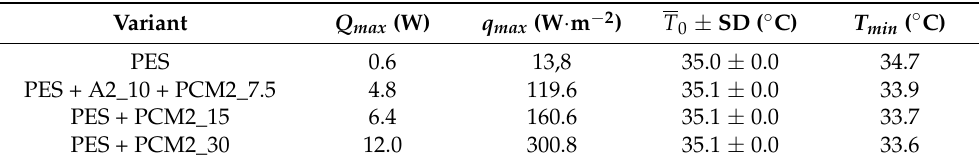
Figure 10. The course of changes in the mean values of heat loss flux density on the skin model (under isothermal conditions). (under isothermal conditions). Table 5. Maximum values of heat loss flux ( Q max ) and heat loss flux density ( H max ) of the skin model and temperature values of the measuring plate of the skin model: average from 5 min before placing the sample ( T 0 ) and minimum value after placing the sample ( T min